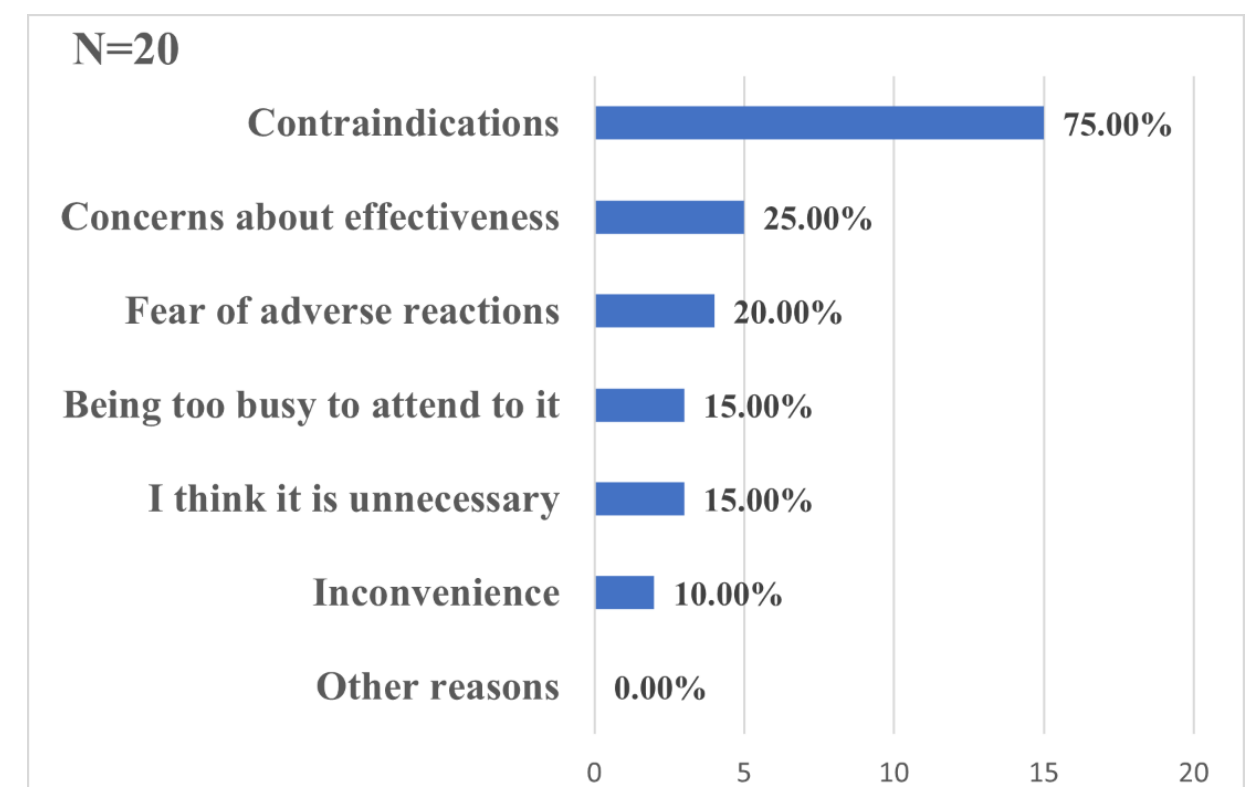
Figure 1. Flow chart of selection and analyses of the study respondents. * refers to the respondents who have completed vaccination. † refers to the respondents who have received a booster dose.